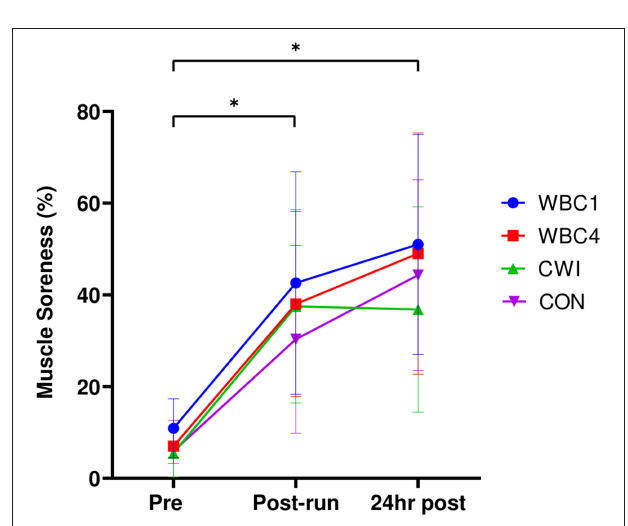
FIGURE 3 | Maximal muscle torques for WBC1, WBC4, CWI and CON groups. * p < 0.05 for decrease in WBC4 and CON only. Data presented as means ± standard deviations. N =